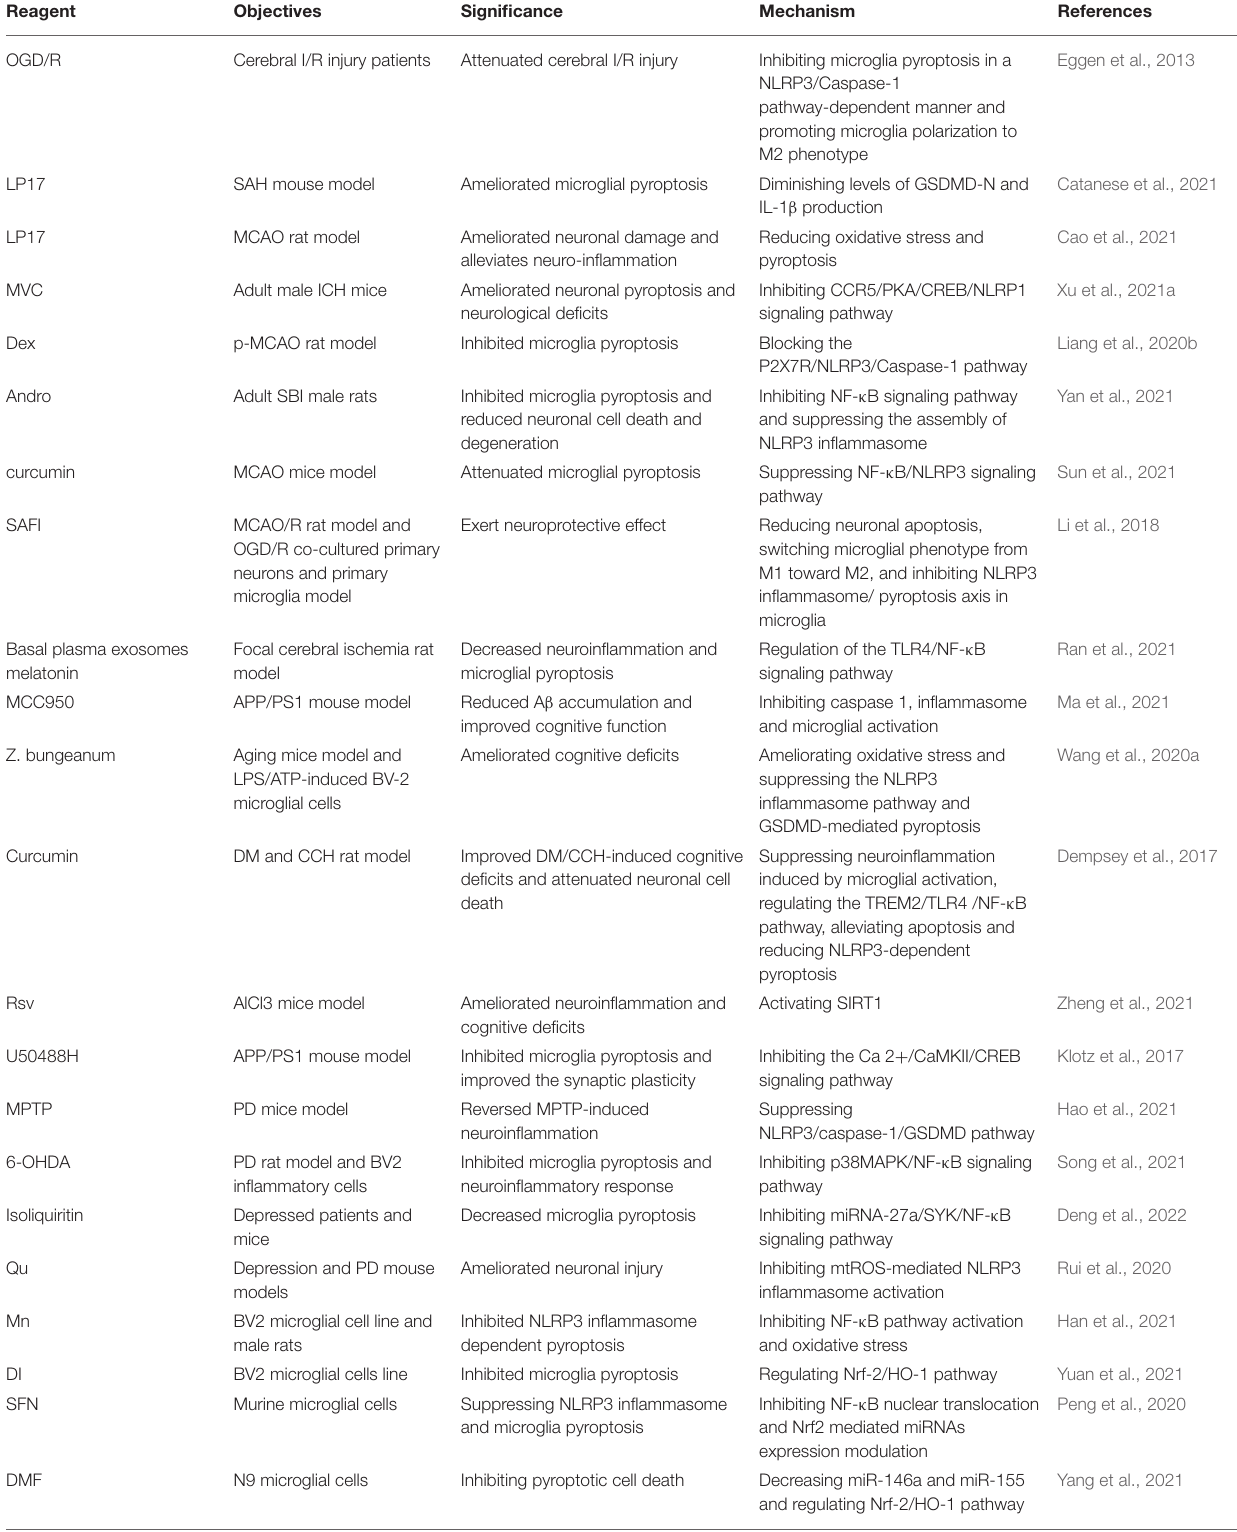
TABLE 1 | Regulation of microglia pyroptosis by various reagents for treatment of neurological diseases.